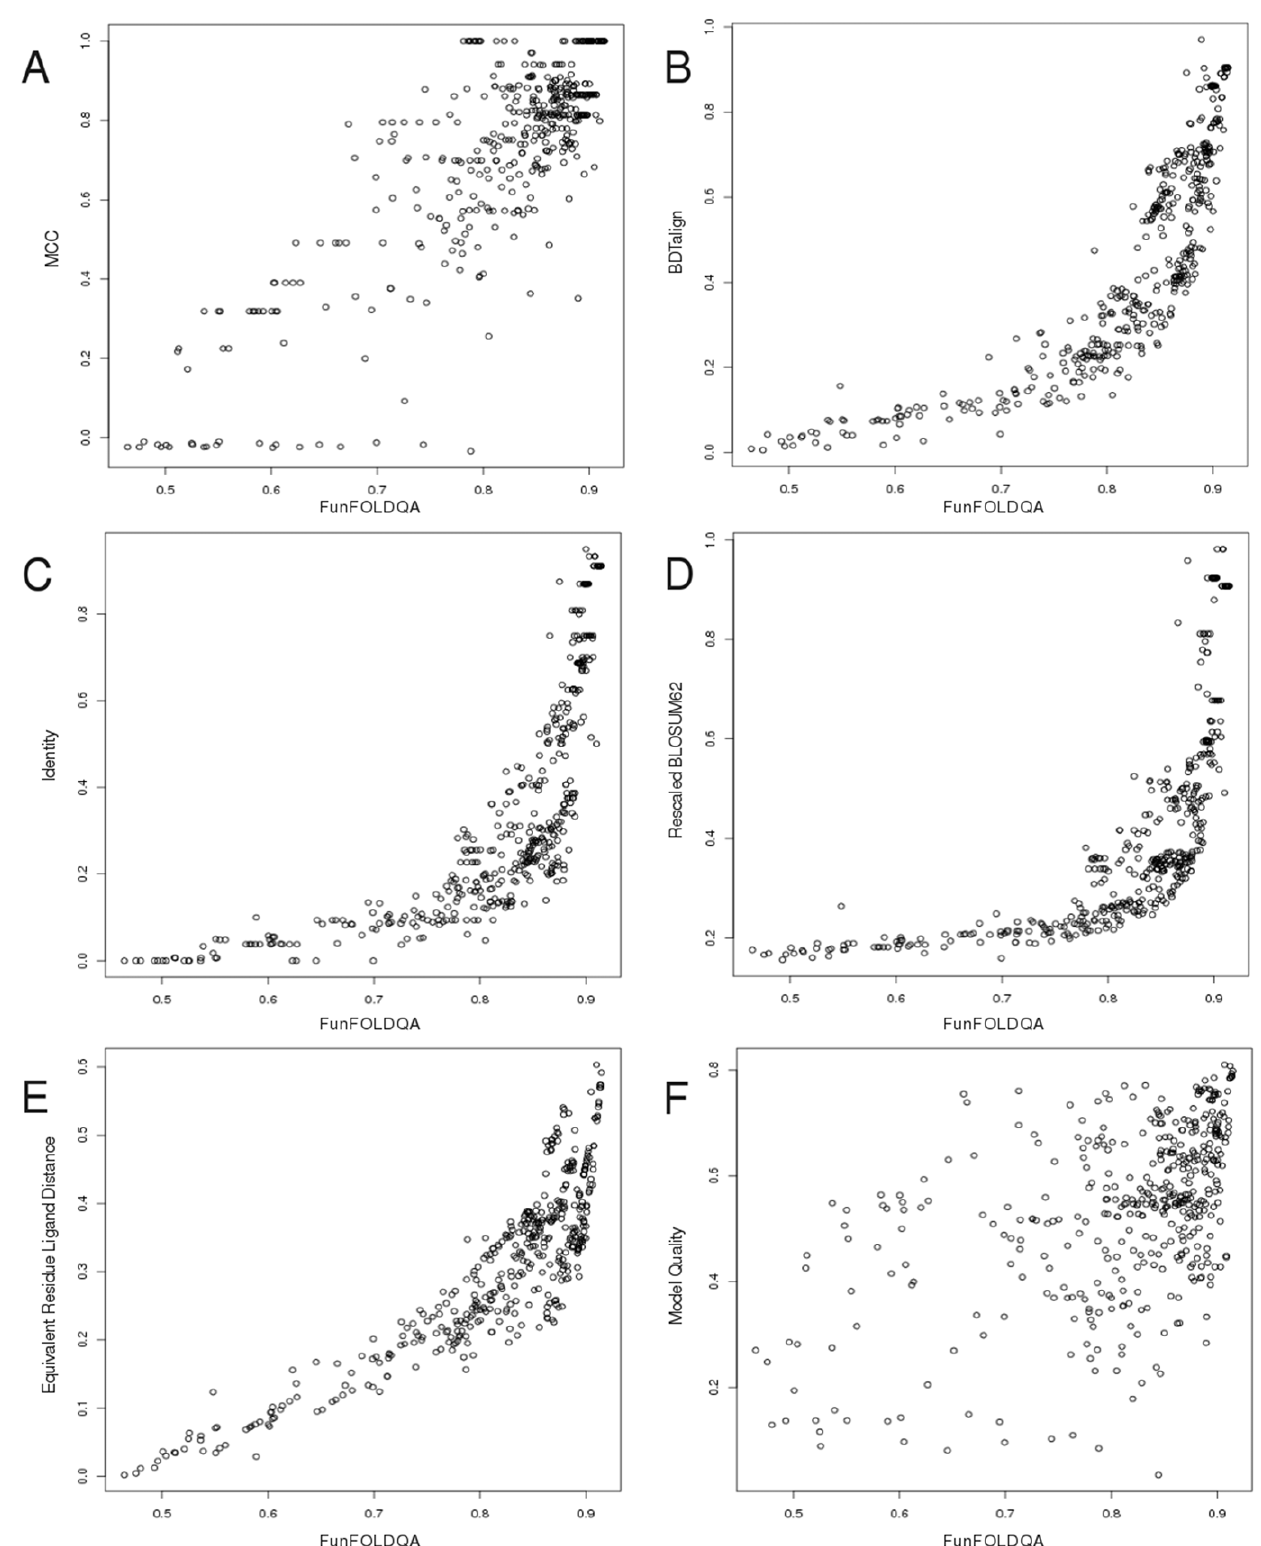
Figure 3. The FunFOLDQA Neural Network scores compared with the observed MCC scores and the feature component scores (CASP8 data). A) The FunFOLDQA Neural Network is plotted against the observed MCC score. B) The BDTalign score. C) The Identity score. D) The Rescaled BLOSUM62 score. E) The Equivalent Residue Ligand Distance score. F) The 3D Model Quality score (ModFOLDclust2).